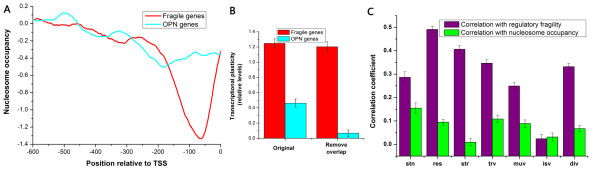
Fragile transcriptional regulatory program is a major source of expression variability. (A) Average nucleosome profiles in promoter regions are shown for fragile genes (red) and OPN genes (cyan). OPN genes have higher nucleosome occupancy close to the TSS. (B) Comparison of transcriptional plasticity was performed between fragile genes (red) and OPN genes (cyan). Values were normalized, such that their means are zero and standard deviations are one. When removing the genes that are shared by fragile genes and OPN genes, the difference became more significant and OPN genes have transcriptional plasticity comparable to genome-wide level. (C) Multiple regression analysis of two properties influencing seven measures for expression variability, including stochastic noise (stn), responsiveness (res), stress response (str), trans variability (trv), mutational variance (muv), interstrain variation (isv) and expression divergence (div). The effects of fragile transcriptional regulatory program (purple) and the presence of nucleosomes close to the TSS (green) on expression variability were estimated by multiple linear regression of the two properties. Error bars in B and C were calculated by bootstrapping.